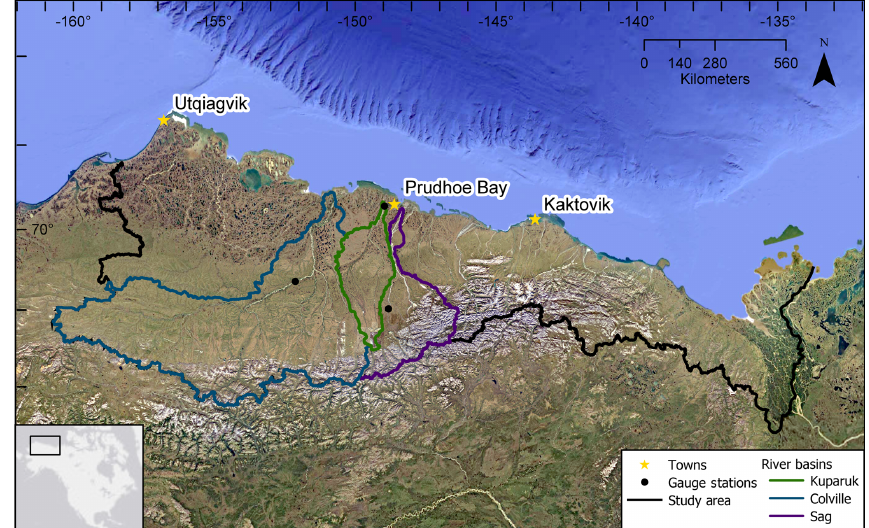
Figure 1. Study domain of North Slope of Alaska. Black line delineates the full North Slope drainage basin. This domain includes all land (196060km 2 ) which drains to the Beaufort Sea coast. Blue, green, and purple lines mark boundaries for the drainage basins of the Colville, Kuparuk, and Sagavanirktok rivers, respectively. The three dots mark locations where USGS discharge measurements are obtained for each river at, respectively, Umiat, Deadhorse, and Pump Station 3. The 42 individual basins defined by the simulated topological network (STN) are listed in Table S1. Locations shown for population centers Utqiagvik, Prudhoe Bay, and